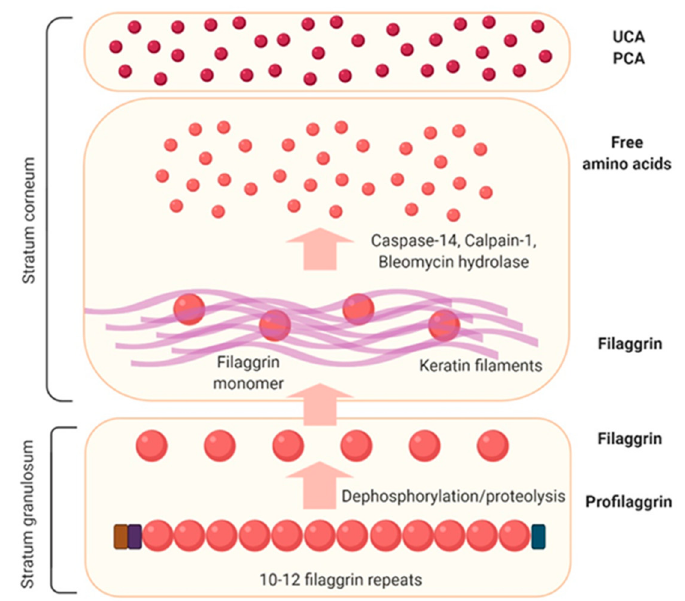
Figure 3. Life cycle of filaggrin. Filaggrin exists as profilaggrin within keratohyaline granules in the granular layer of the epidermis. Profilaggrin is degraded to form filaggrin during the terminal di ff erentiation process. Then, in the upper part of the stratum corneum (SC), filaggrin is degraded into amino acids and plays a crucial role in maintaining SC hydration and pH by forming natural moisturizing factors, including pyrrolidine carboxylic acid (PCA) and urocanic acid